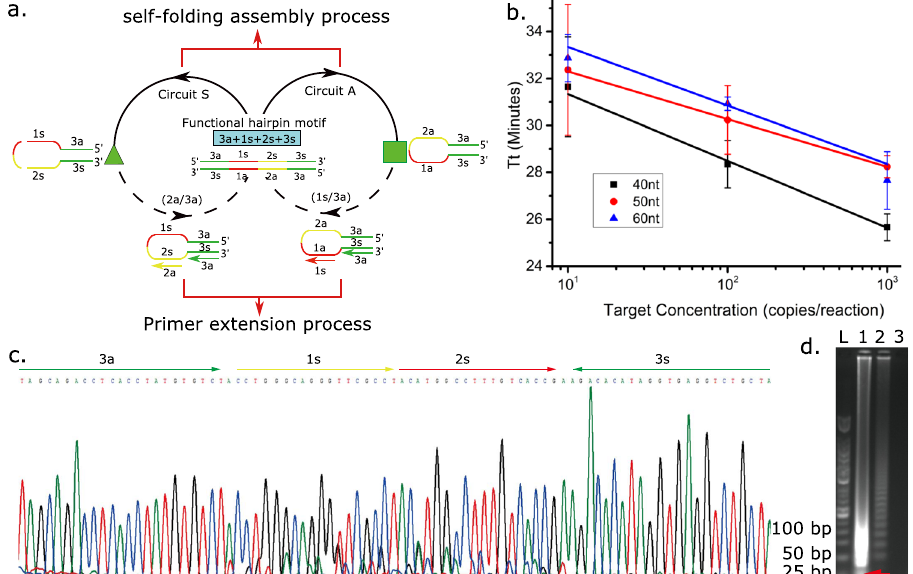
Fig. 1 Programming a nucleic acid isothermal ampli fi cation pathway as a reaction graph. Programming a nucleic acid isothermal ampli fi cation pathway as a reaction graph in which the hairpin complex acts as the initiator and encodes two priming sites in the loop region: ( a ) A schematic for generating the secondary structure mechanism and reaction graph from the functional hairpin motif-mediated isothermal ampli fi cation. The letters a/s denote the complementarity of the nucleic acid sequence and the numbers represent speci fi c fragments in the functional hairpin structure (e.g. 2a is complementary to 2s). During their ampli fi cation, the functional hairpin motif double strand product (blue box) disassembles (solid arrows) to form sense (green triangle) and anti-sense (green square) strand products. The formation of self-folding products exposes the priming sites which leads to the hybridisation of the primers and extension of the sequence by the strand-displacement DNA polymerase (dashed arrows) to generate a double strand amplicon. The amplicon then becomes the target (or initiator) for further ampli fi cation cycles via circuit S and A; b The reaction kinetics of the mechanism described in Fig. 1a with different lengths of loop fragment from 40 nt (black squares), 50 nt (red disk) and 60 nt (blue triangle). Data are presented as mean values; error bars are standard deviation, N = 3 independent experiments; c Sequencing of product (3a + 1 s + 2 s + 3 s) where the ampli fi cation products were digested (lane 1 in ( d )), cloned and sequenced, identifying as tandem repeats; d Agarose gel electrophoresis of the ampli fi cation products. Lane L: 50 bp ladder; Lane 1: ampli fi cation product digested by the restriction enzyme Xba I. Lane 2: ampli fi cation product (with initiator); Lane 3: ampli fi cation product (without initiator). The gel is representative of experiments repeated independently three times with similar results. Source data are provided as a Source Data fi